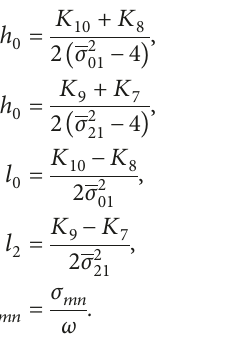
Figure 12: Time history of the surface wave height at the container wall under the lateral harmonic excitation for r (a), 0.3m (b), 0.5m (c), and 0.7 m (d),